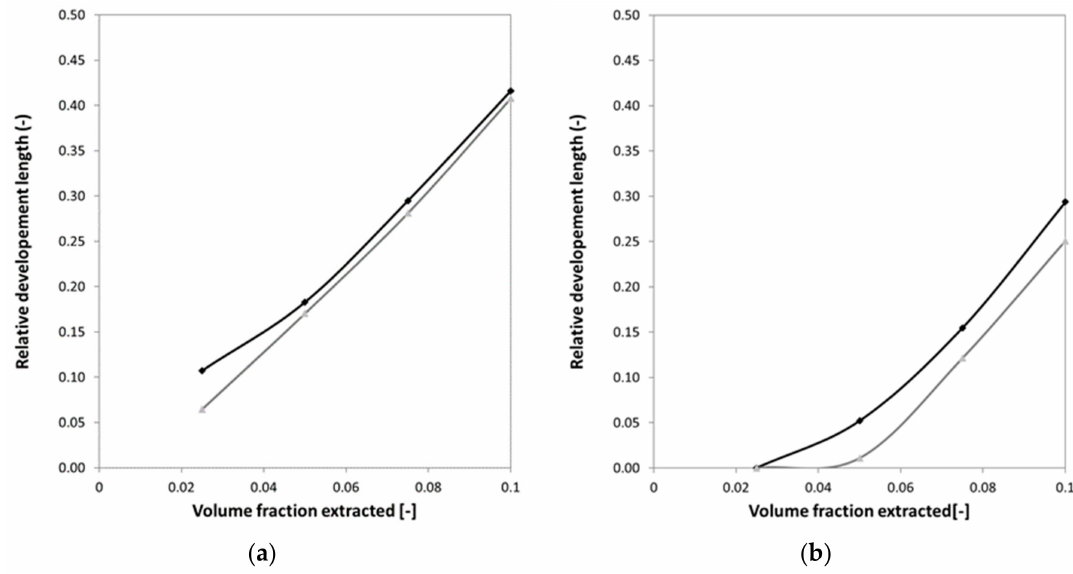
Figure 11. Relative development length at the center of the channel (95%) between the recover section and the entrance section versus the volume fraction extracted from the inlet for a bulk particle volume fraction of 10% ( a ) and 30% ( b ). Each graph shows two different lines for the different channel heights: 50 µ m (black) and 100 µ m (grey).